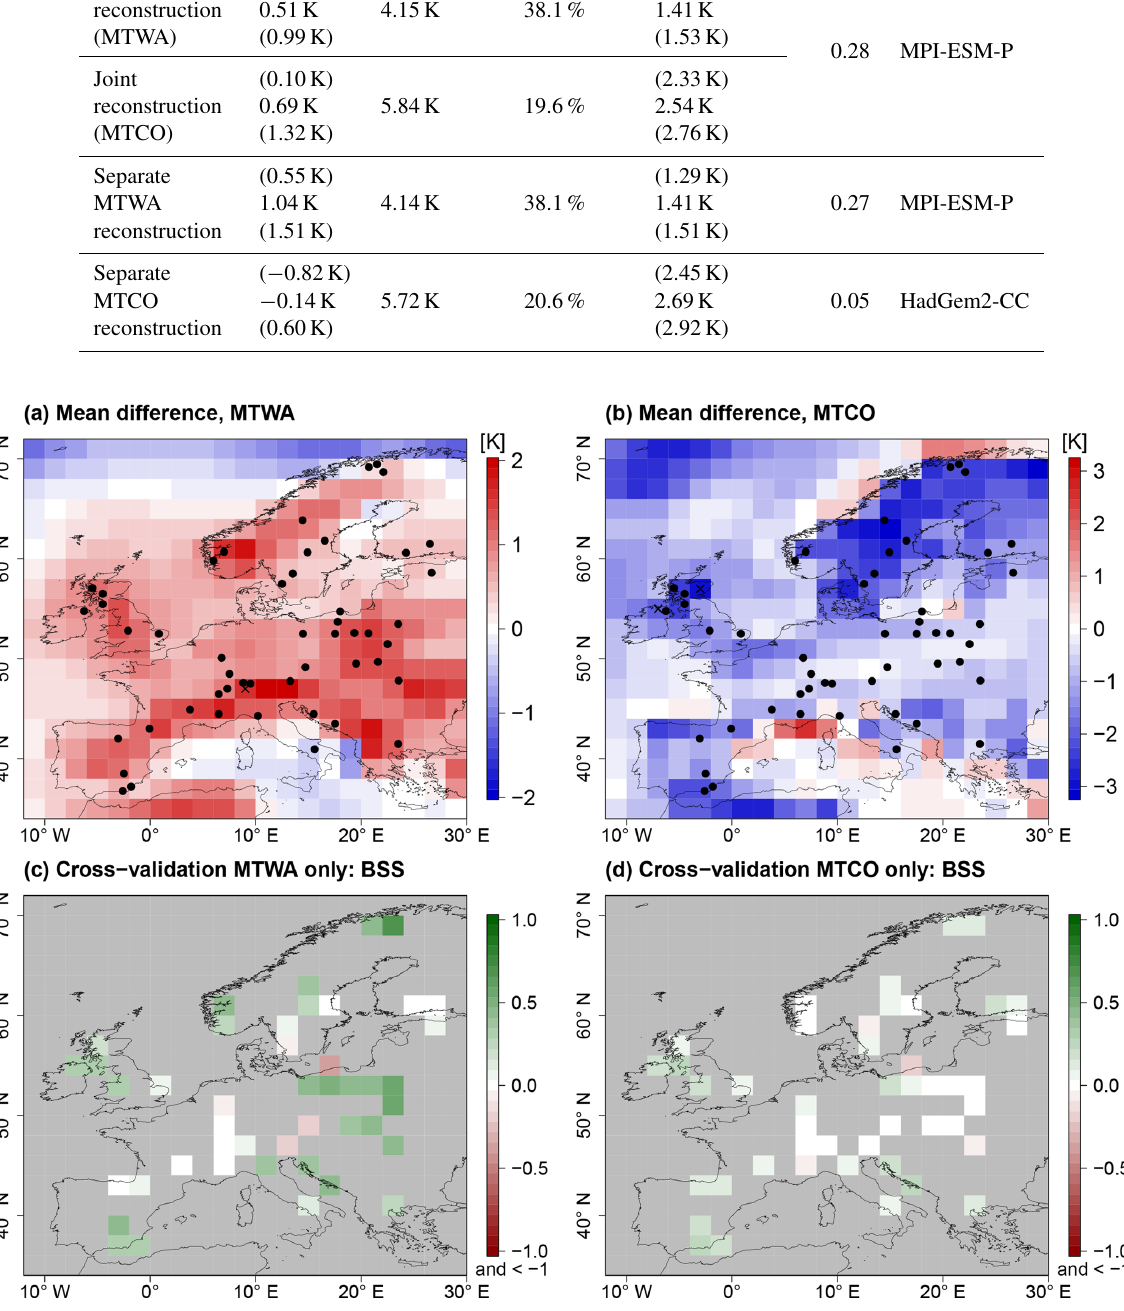
Figure 10. Differences of joint and separate reconstructions of MTWA and MTCO. (a, b) Posterior mean difference; point-wise signif- icant differences (5% level) between the separate and the joint reconstructions are marked by black crosses. (c, d) BSS of the separate reconstructions. Black dots depict proxy